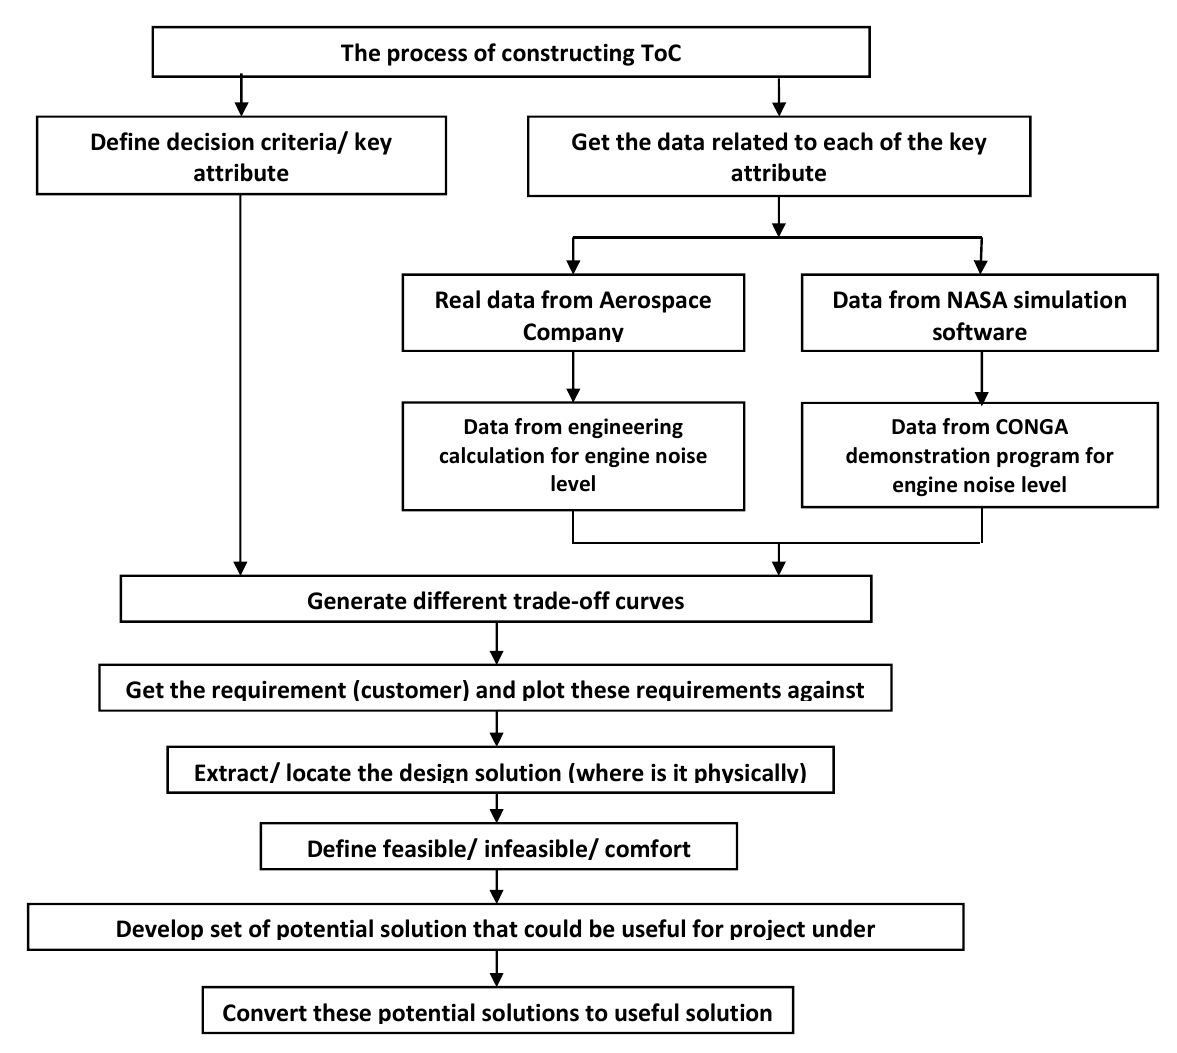
Fig. 1. The process of constricting